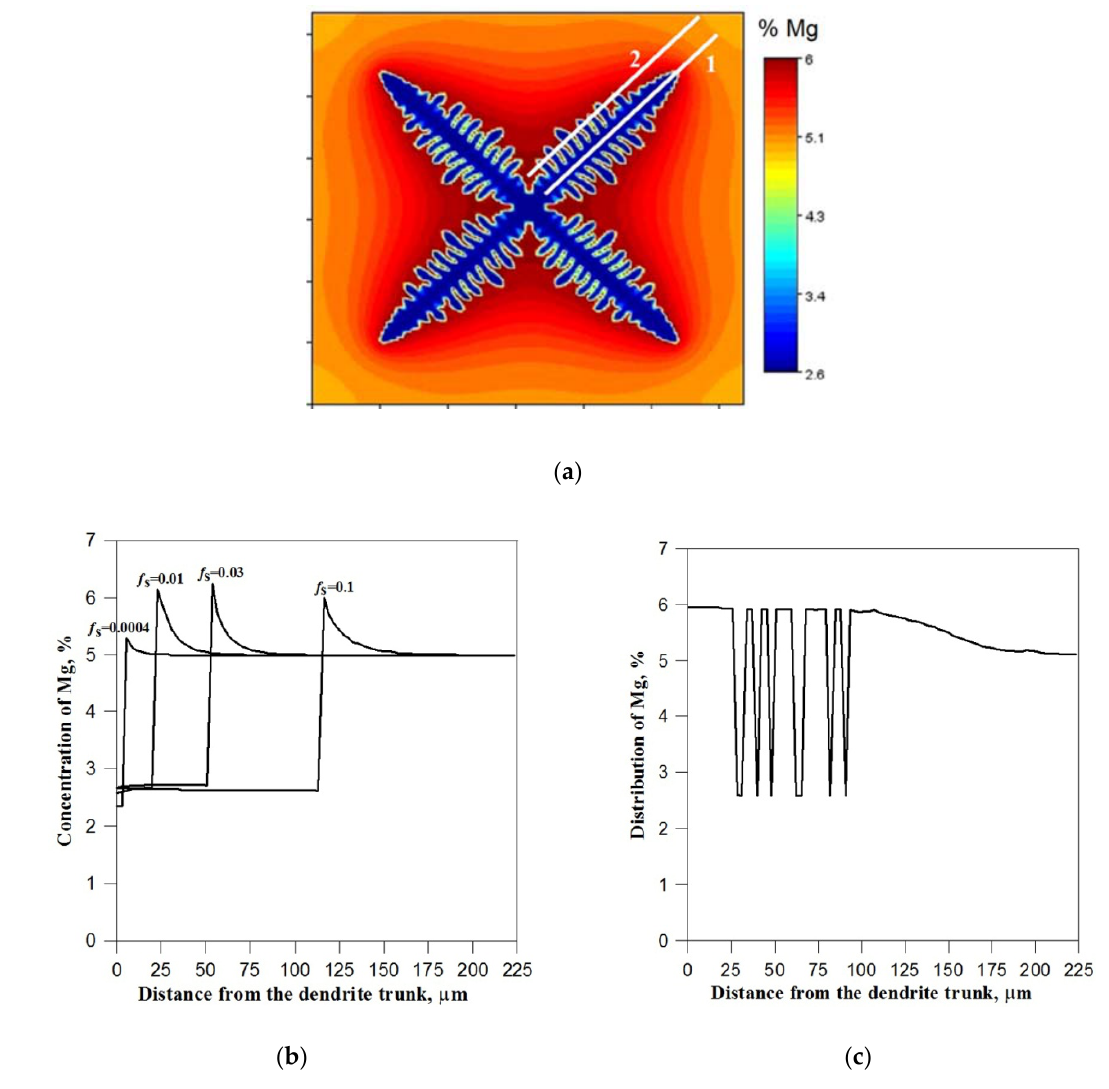
Figure 3. The results of the simulation of the equiaxial dendrite growth for the cooling rate of 45 K/s: ( a ) the morphology of the dendrite with orientation θ 0 = 45°, ( b ) Mg concentration profiles during dendrite growth determined along line 1, ( c ) magnesium distribution along the section starting from the base of the dendrite and crossing the secondary arms (line 2) − f S = 0.1.